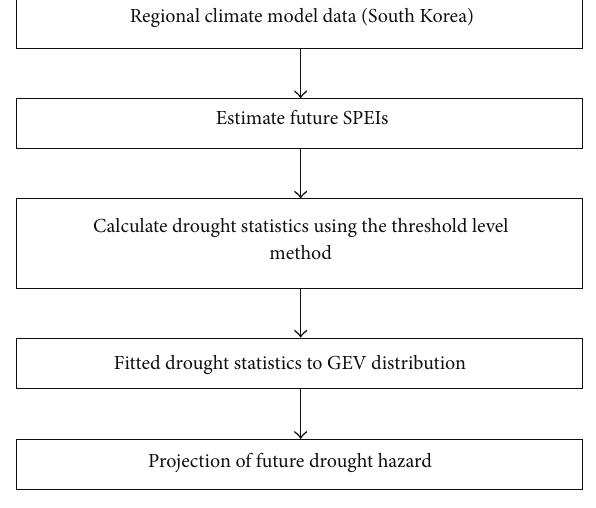
Figure 1: Procedure of this study.